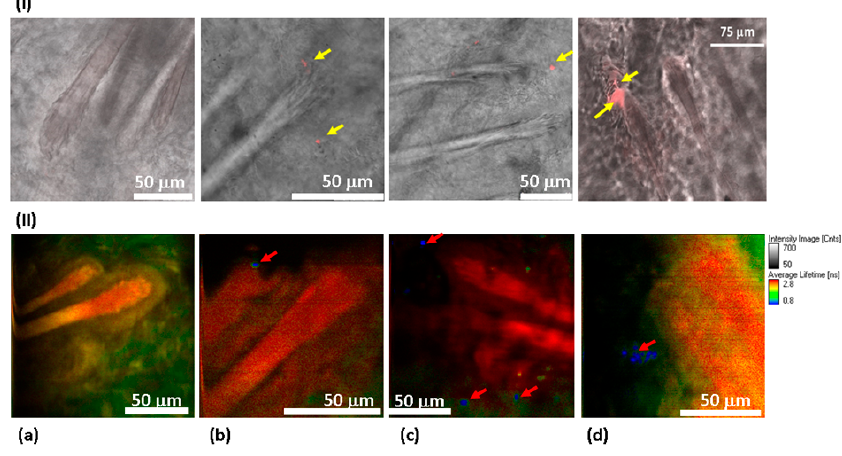
Figure 6. Distribution of 100 ND in the skin using confocal imaging ( I ) and FLIM ( II ). 40 × objective lenses (oil immersion for confocal measurements) were used. In confocal imaging ( I ), the fluorescence of 100 NDs was due to excitation at a 532 nm wavelength and was detected in the 650–720 nm range. In FLIM ( II ), a two-photon fluorescence was excited with an 800 nm femtosecond laser, and the signal was detected in the spectral range of 450–650 nm. ( I ) Skin sections observed using a confocal scanning microscope to visualize the fluorescence of 100 ND. No fluorescence signal was detected in the control sample ( I ( a )), while the treated sample presents a clear signal corresponding to the presence of 100 ND in di ff erent compartments of the hair follicles (shown in red and marked with yellow arrows) ( I ( b – d )). ( II ) FLIM: ( II ( a )) control sample. No fluorescence which could be related to 100 ND is detected. ( II ( b – d )) 100 ND-treated samples. The short lifetime signal (shown in blue) is visualized, which is characteristic of 100